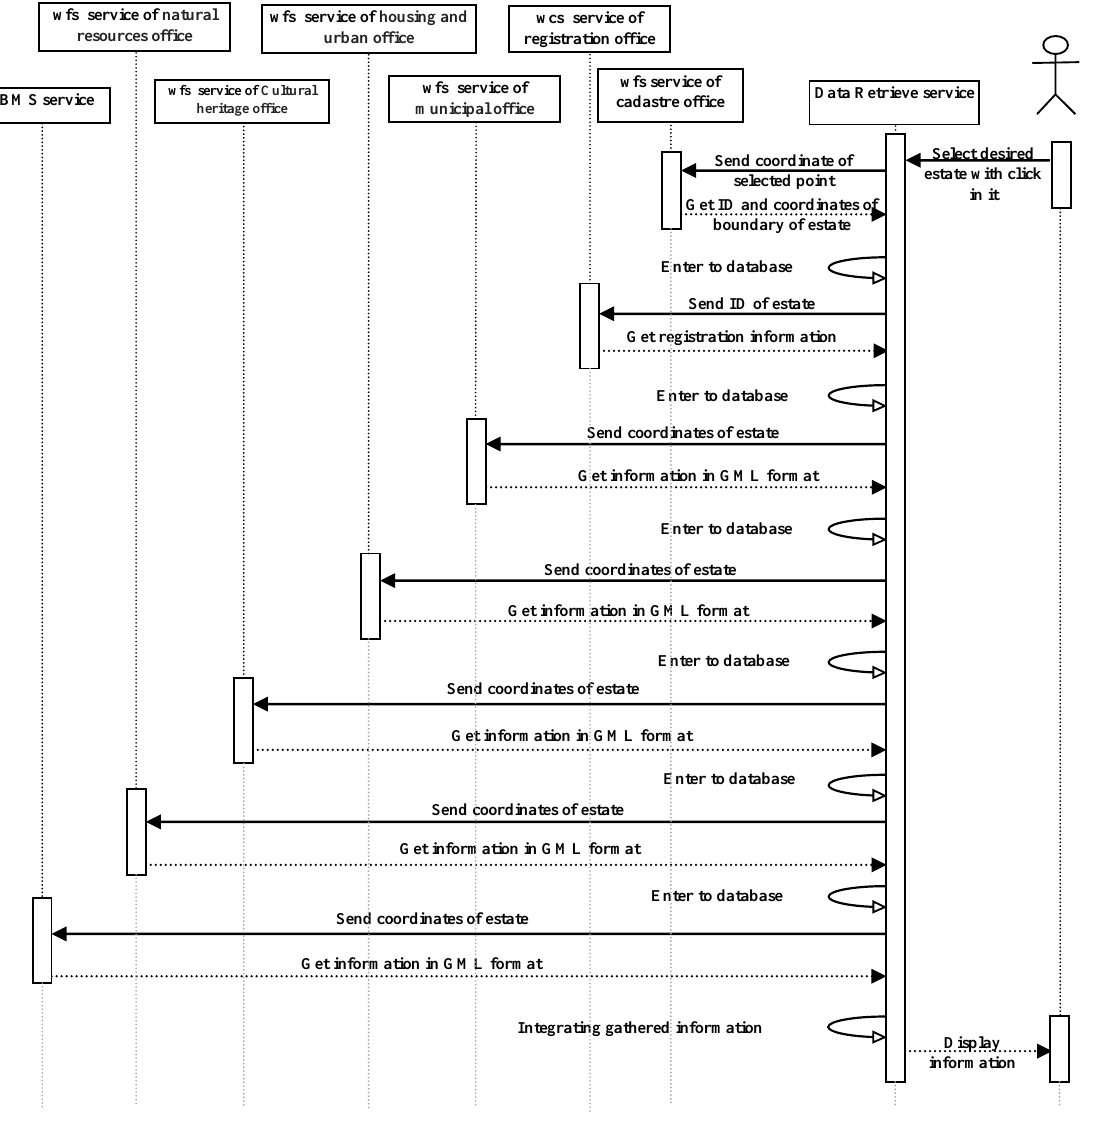
Figure 4. UML sequence diagram for data retrieving